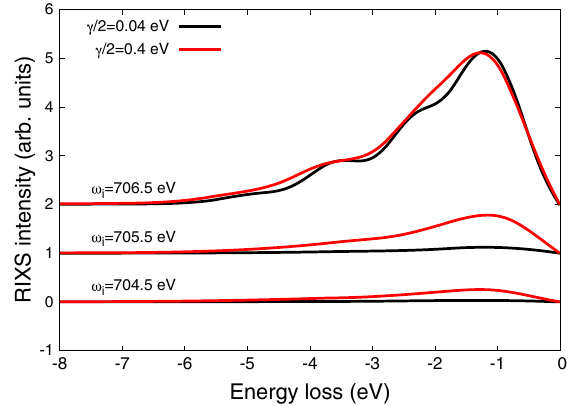
FIG. 14. Bethe-Salpeter equation calculations of the direct RIXS response of BaFe 2 As 2 at and below the Fe L 3 XAS threshold for core-level broadenings of 0.04 and 0.4 eV. The longer core-hole lifetime (black curves) attenuates the RIXS signal below threshold more